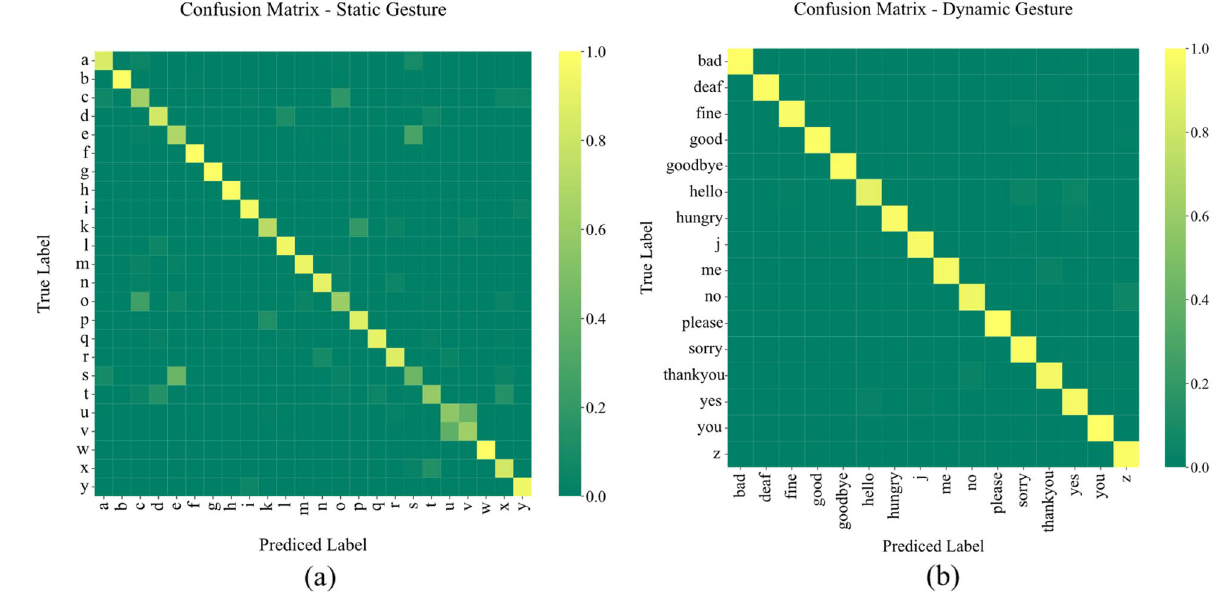
Figure 6. Confusion matrices: ( a ) confusion matrix for the static signs; ( b ) confusion matrix for the dynamic